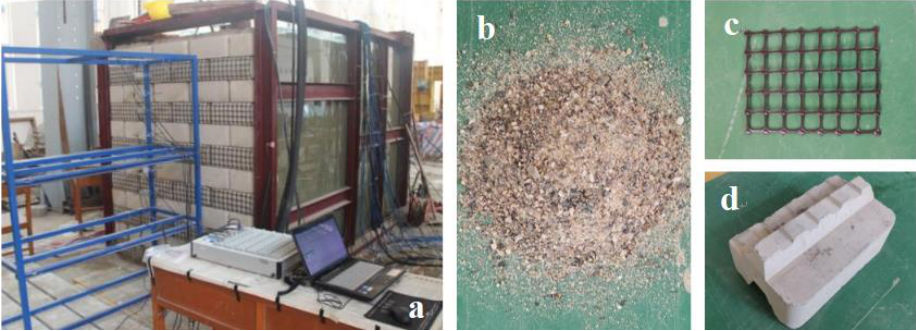
Figure 2. Preparation: ( a ) test site layout; ( b ) sand; ( c ) geogrid; ( d )